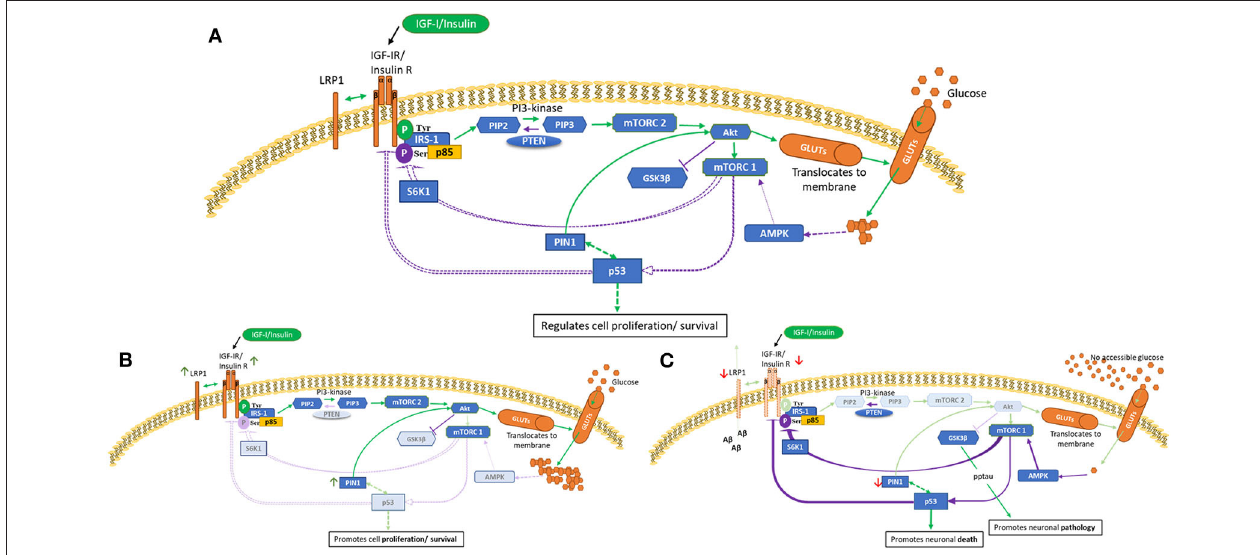
FIGURE 1 | PI3K/Akt pathway in health (A) , cancer (B) and AD brain (C) cells. This is a schematic of the PI3K/Akt cellular pathway which regulates cell proliferation, metabolism and death. These figures attempt to highlight possible differences in cancer and AD compared with health. These indicated differences, as described in human and animal tissues and in cell culture, are meant to represent general concepts not specific cases. (A) shows normal regulation (B) indicates a cancer phenotype (C) illustrates AD as an insulin-resistant state i.e., T3DM. Green lines represent activation and purple lines represent feedback from the activation pathway. Activation of the IGF-1/insulin receptors leads to tyrosine phosphorylation of IRS-1 and activation of mTORC2 and Akt, resulting in glucose uptake. Homeostasis is maintained partly by mTORC1 sensing of metabolic conditions, which, as appropriate, leads to phosphorylation of p53 and S6K1 serine phosphorylation of IRS-1. p53 is a negative regulator of IGF/insulin receptors, IGF-II and glucose transporters. [A] Normal cellular homeostasis as described above [B] In cancer, negative feedback pathways are switched off leading to upregulation of proliferation, metabolism and cell survival. A modified genetic landscape (e.g., p53, PTEN) enables tumor cells to benefit from a glucose-rich, IGF/insulin-rich environment (insulin-resistance such as in T2DM).In cancer, Akt can phosphorylate and inactivate GSK-3 β , which results in increased protein synthesis that supports cell growth. [C] In AD brain with insulin-resistance, or if, due to decreased blood flow there is no glucose accessible, the PI3K/Akt pathway is effectively switched off or downregulated. This leads to upregulation of GSK- β that culminates in tau phosphorylation and aggregation and increased amyloid beta production. Lack of intraneuronal glucose would trigger AMPK to activate mTORC1, p53, S6K1 serine phosphorylation of IRS-1. This could be a self-perpetuating